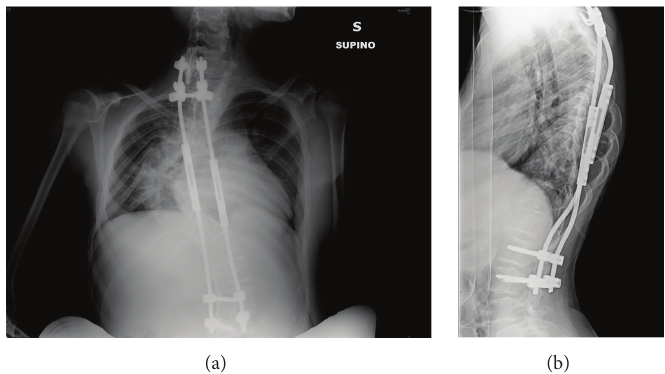
Figure 1: Anteroposterior (a) and lateral (b) chest X-ray showing patient’s pronounced spinal curvature and dorsal hump. A provisional extensible distractor is in